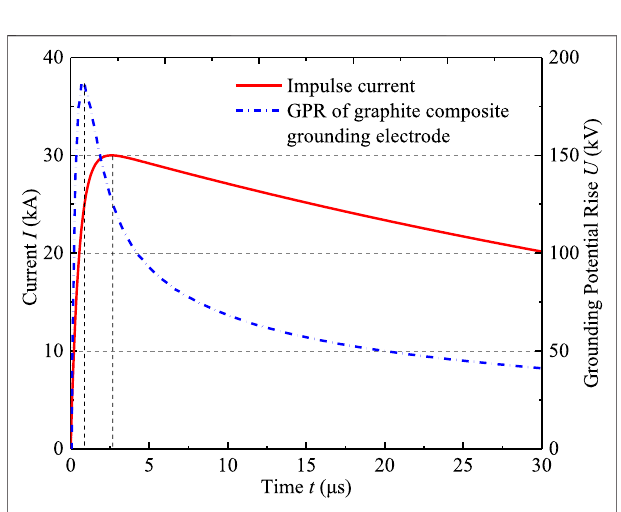
FIGURE 13 | Waveform of grounding potential rise when inductance effect is dominant.